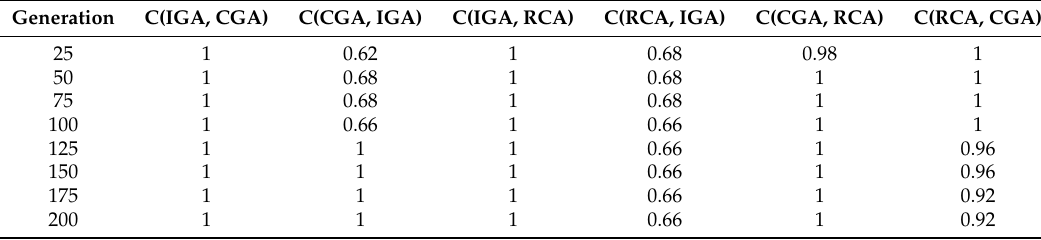
Table 7. Coverage ratio analysis for IGA, CGA, and